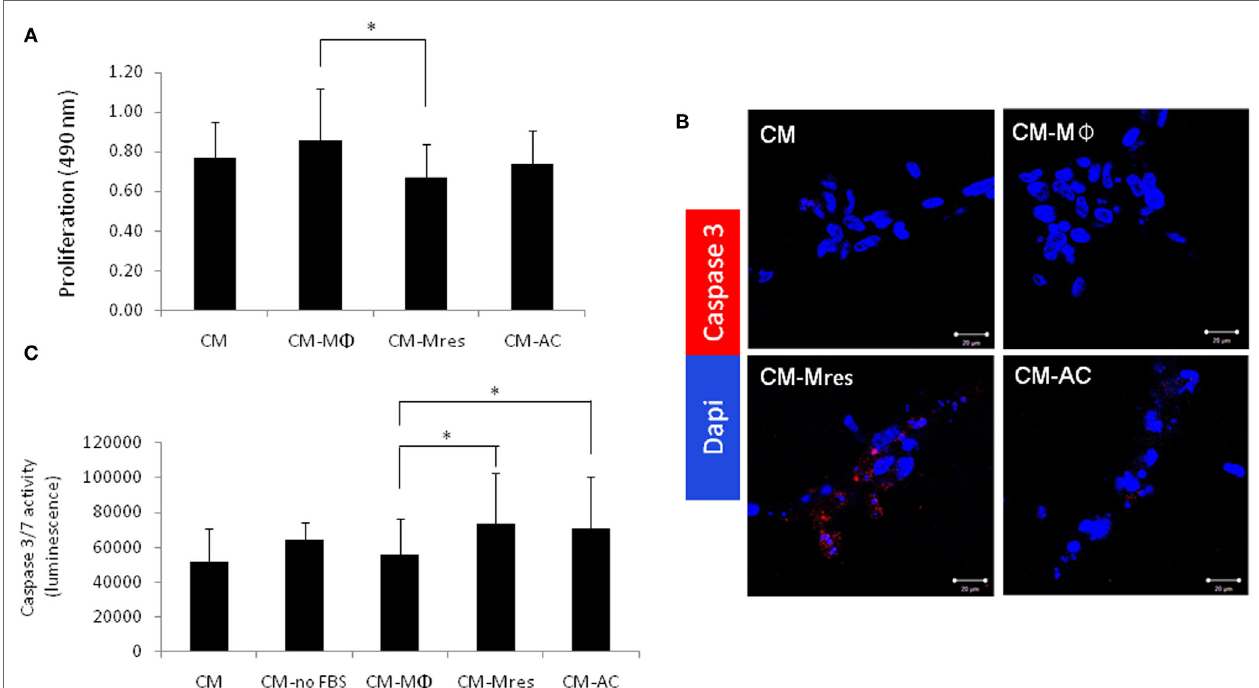
FigUre 1 | CM-Mres inhibits proliferation and induces apoptosis of human umbilical vein endothelial cell (HUVEC). HUVEC were cultured on basement membrane extract and treated with condition medium (CM), CM-M ϕ , CM-Mres, or CM-AC. (a) Representative proliferation of HUVEC after overnight treatment. n = 5 with four to five replicates. (B) Representative confocal images of HUVEC stained for activated caspase 3 (red) and nuclei (DAPI, blue). Magnification 40 × , bar = 50 µm. (c) Caspase 3/7 activity in HUVEC either starved [CM-no-fetal bovine serum (FBS); positive control] or treated with the indicated conditioned media overnight. Columns; mean, bars; STD, n = 6 with three replicates for each experiment. One-way repeated measures ANOVA analysis with repeated contrasts, * p ≤